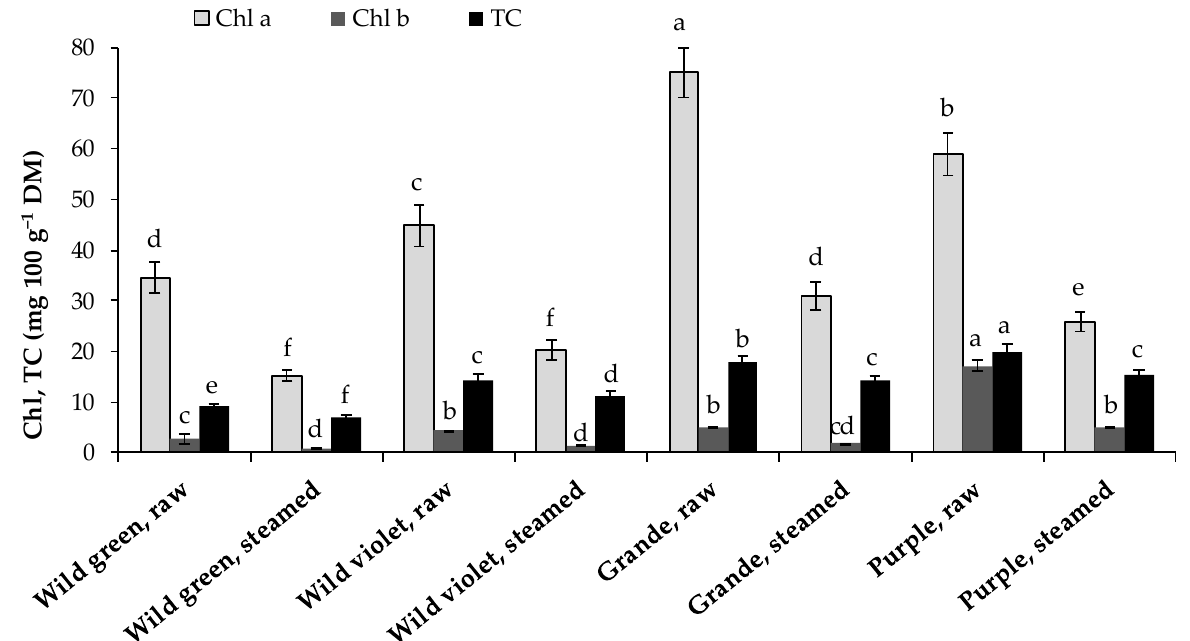
Figure 5. Content of chlorophyll (Chl) a and b, and total carotenoids (TC), in raw and steamed asparagus ( p ≤ 0.001). ‘Bianco di Bassano del Grappa’ is missing because the three pigments shown in the graph were not detected. For columns of the same parameter equal letters indicate that the mean values are not significantly different ( p = 0.05). Vertical bars indicate the standard deviation. Grande = ‘Grande’; Purple = ‘Purple Passion’.